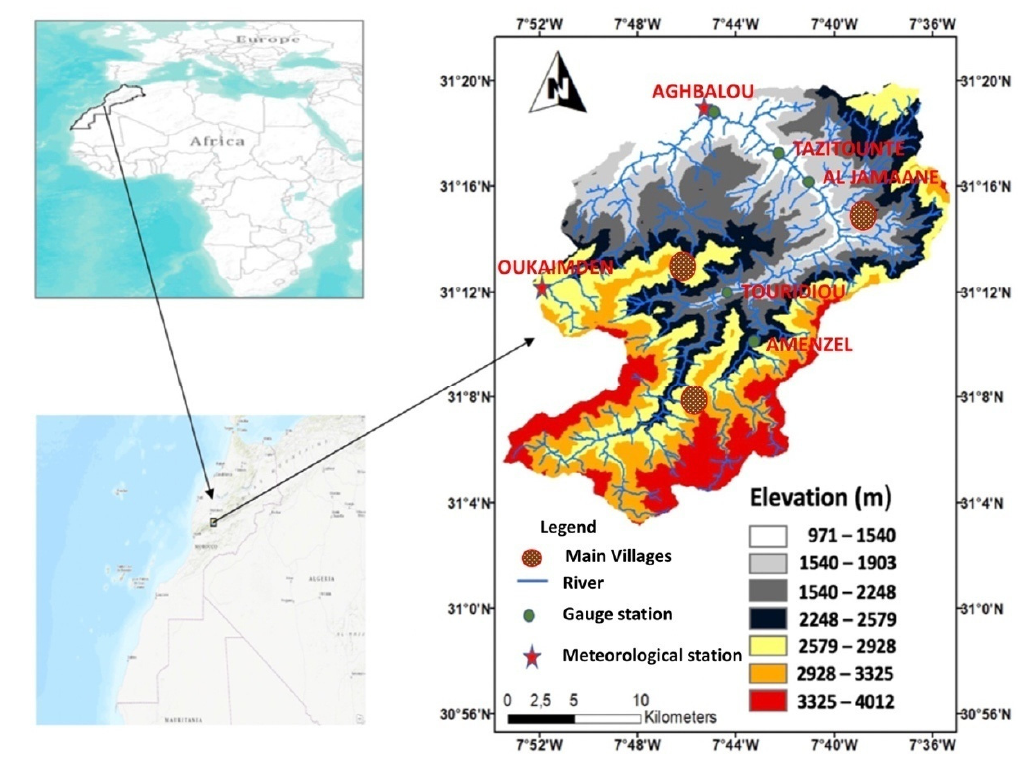
Figure 1. The study area map showing the locations of the river, stream flow gauges, climate stations, villages and elevation.